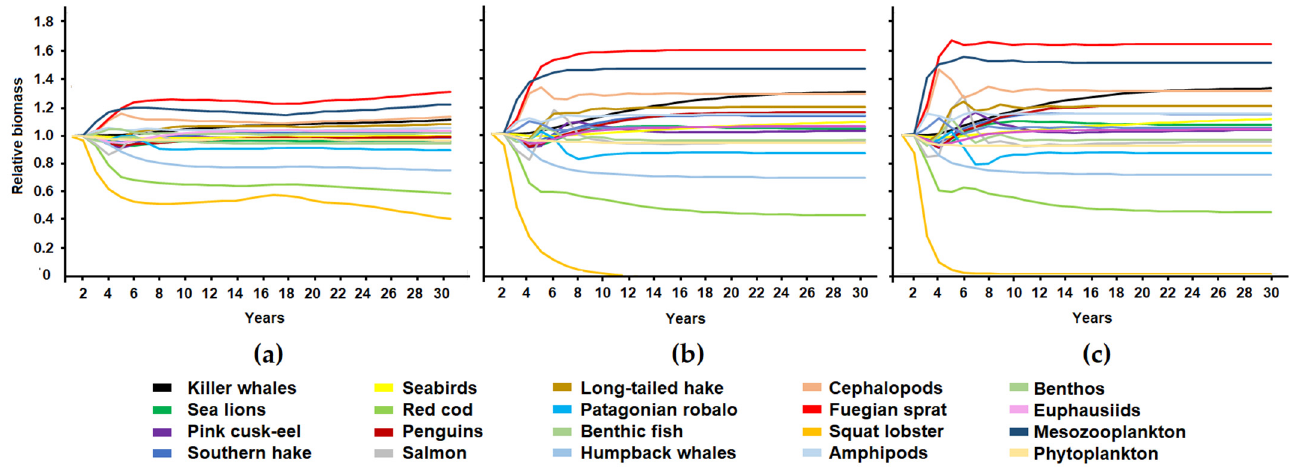
Figure 4. Changes in the relative biomass of the functional groups of the ecosystem in three simulated scenarios for squat lobster showing fishing extraction of 10 ( a ), 25 ( b ), and 50% ( c ) of its bio- mass.